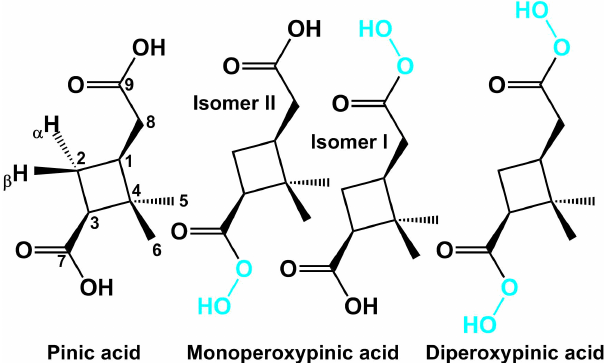
Figure 1. Structures of cis -pinic acid and its peroxy acid derivatives synthesised and characterised in this